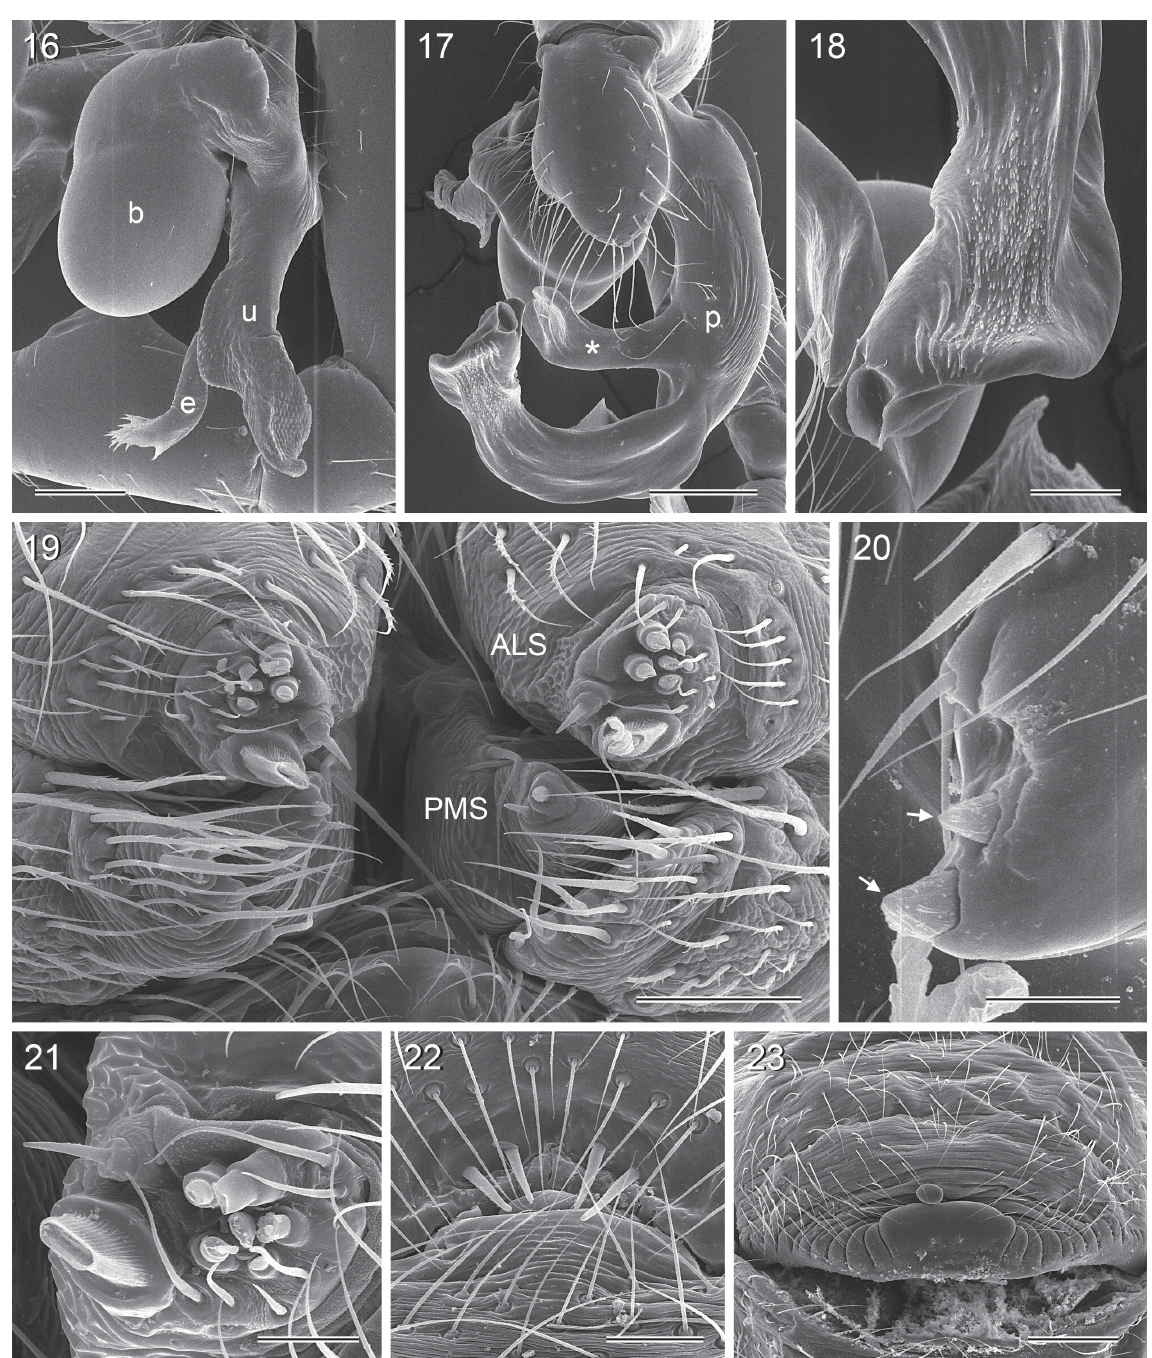
Figs 16–23. Pholcus olangapo Huber, sp. nov., ZFMK Ar 15497–98. 16 . right genital bulb, prolateral view. 17 . Left tarsus and procursus, dorsal view (asterisk marks prolatero-dorsal process of procursus). 18 . Tip of left procursus, dorsal view. 19 . Female spinnerets. 20 . Male cheliceral apophysis (arrows point at modified hairs). 21 . Male ALS. 22 . Male gonopore. 23 . epigynum. Scale lines: 16, 23 = 200 µm; 17 = 300 µm; 18 = 100 µm; 19 = 70 µm; 20–21 = 20 µm; 22 = 40